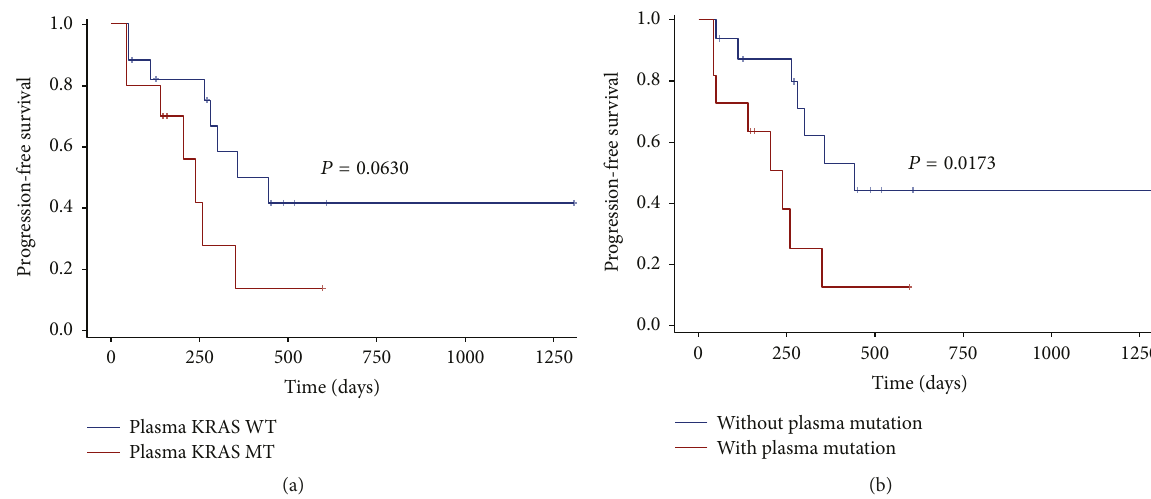
Figure 4: Kaplan-Meier plots of patients for progression-free survival (PFS) grouped by plasma KRAS and RAS/BRAF mutation status. The plasma KRAS mutations were not associated with shorter PFS (median PFS 239 days versus 443 days, 𝑃 = 0.0630 ) (a). However, plasma RAS/BRAF mutations were associated with poor PFS compared to wild type (median PFS 239 days versus 443 days, 𝑃 = 0.0173 , HR = 3.351)